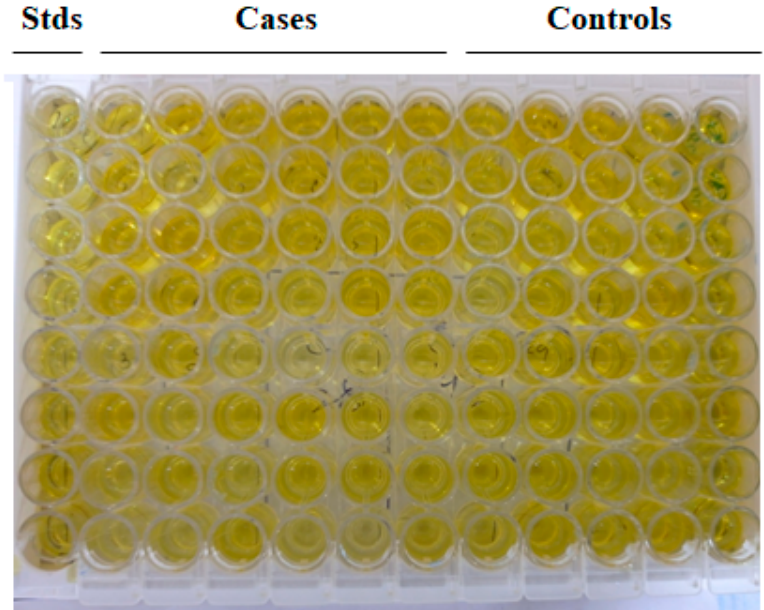
Figure 3. ELISA microtiter wells of IL17A. Standard diluent buffer 1X was taken as zero.